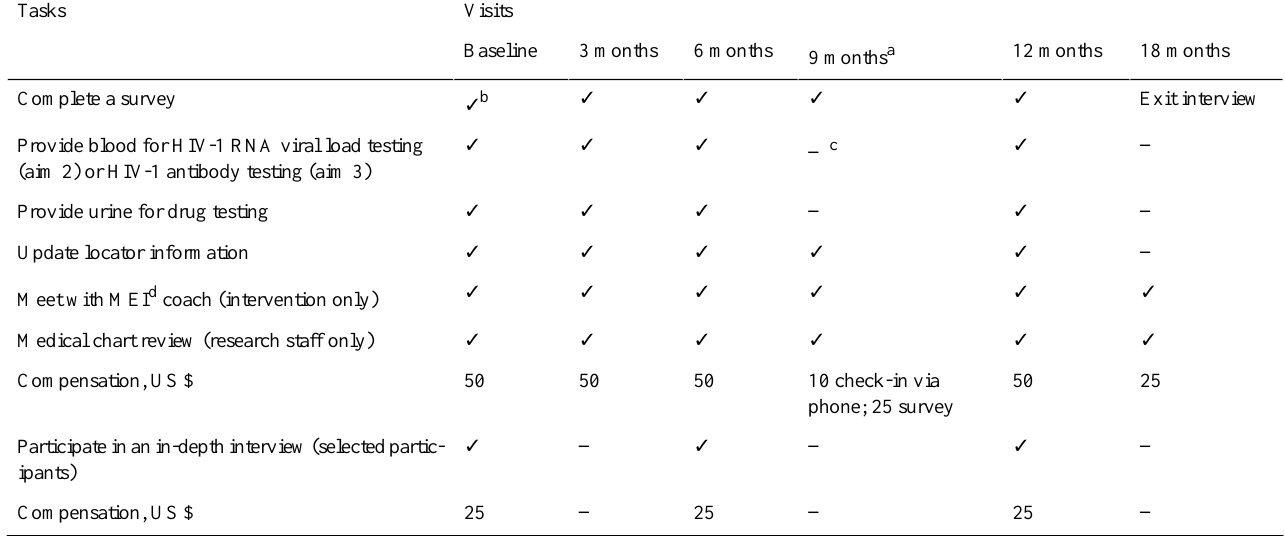
Table 2. Study visits and associated laboratory